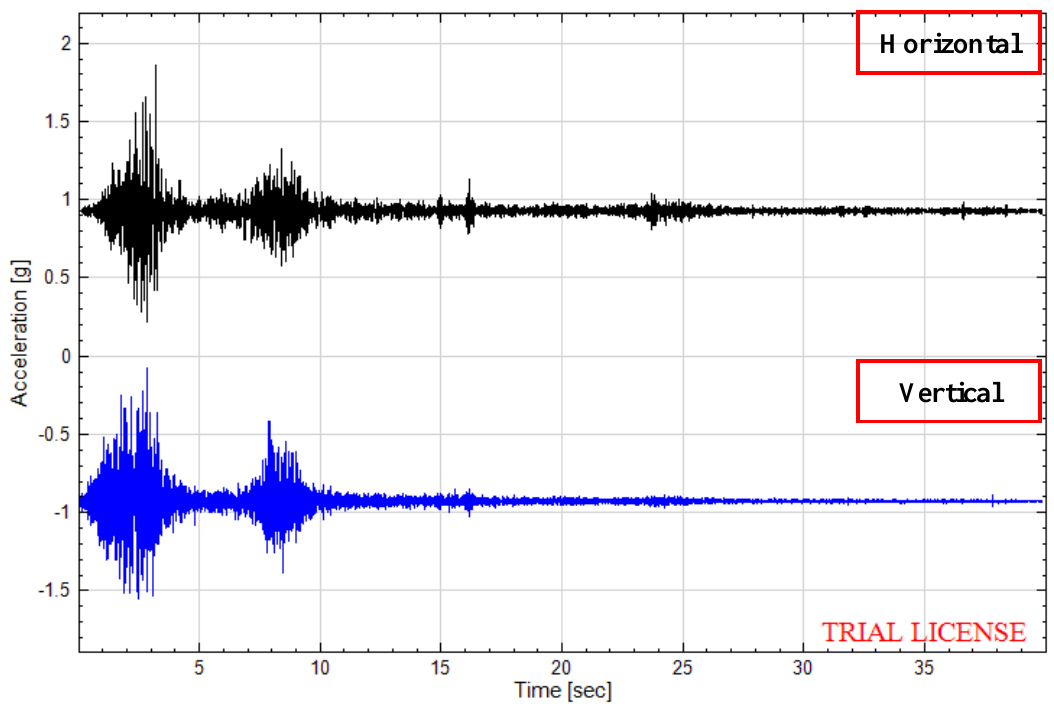
Figure 8. Boundary condition processing.